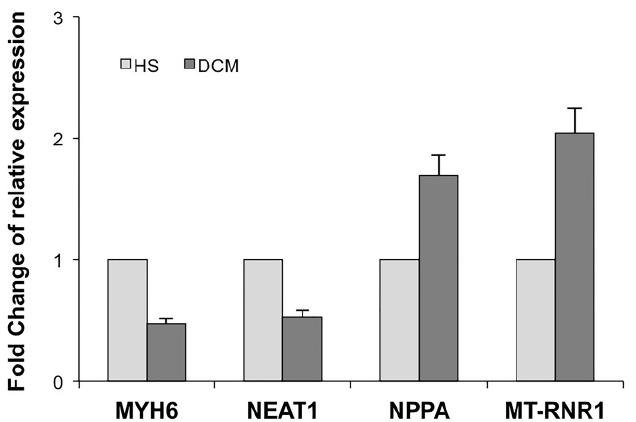
Figure 6. Correlation plot of 13 selected genes (from ML analysis) with seven clinical features. The circled values have a significant correlation ( p < 0.05).